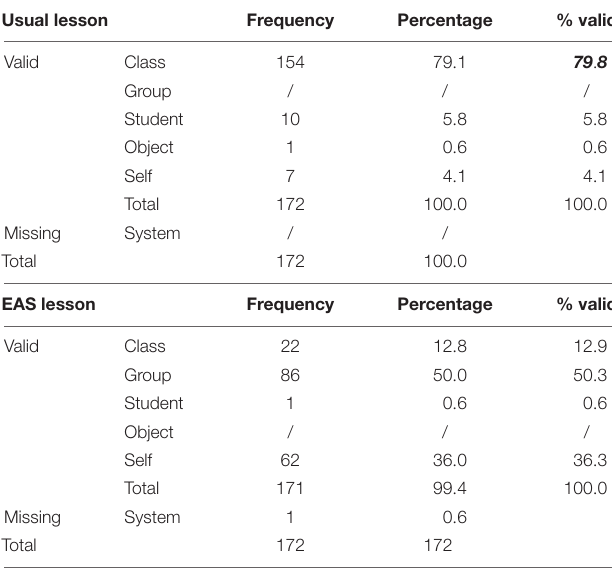
TABLE 6 | Proxemics differences between usual lessons and EAS lessons